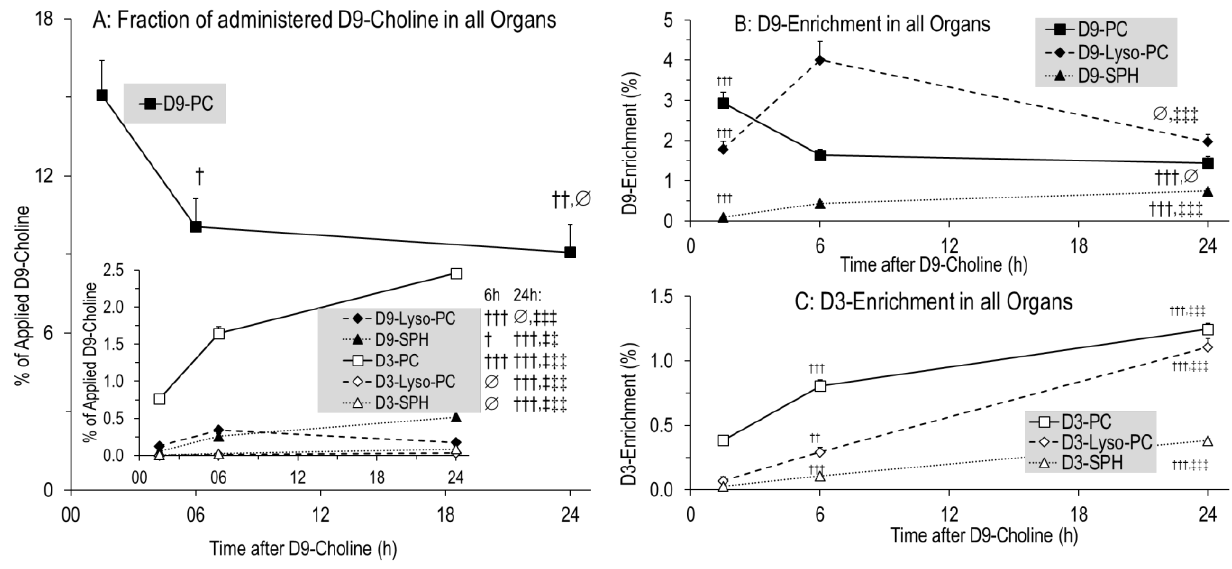
Figure 4. Fractions of administered D9-choline ( A ) and enrichment of D9-choline ( B ) and D3-choline ( C ) labeled phospholipids in the sum of all investigated organs (liver, lung, lung lavage fluid, cerebrum, cerebellum) and total plasma. For fractions of D3-labeled components ( A ), absolute values were divided by 3 as only one of 3 D3-methyl groups of the administered D9-choline are present in the target molecules. Data are means ± SE of 8 – 10 experiments and indicate the kinetics from 1.5 h to 24 h after 50 mg/kg intraperitoneal D9-choline chloride injection. Abbreviations: D9/3-PC, D 9/3 - phosphatidylcholine; D 9/3 -Lyso-PC, D 9/3 -lyso-phosphatidylcholine; D 9/3 -SPH, D 9/3 -sphingomyelin. ∅ , not significant; †, p < 0.05, ††, p < 0.01, †††, p < 0.001 vs. 1.5 h; ‡‡, p < 0.01, ‡‡‡, p < 0.001 vs. 6